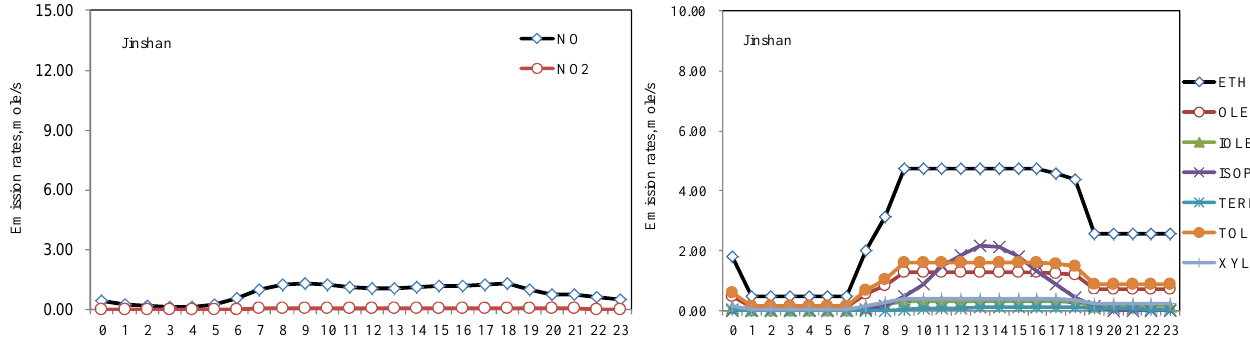
Fig. 11. Emission inputs of NO x and main VOC species at Jinshan Fig.11. Emission inputs of NO and main VOC species at Jinshan site x Nanjing, the capital city of Jiangsu province